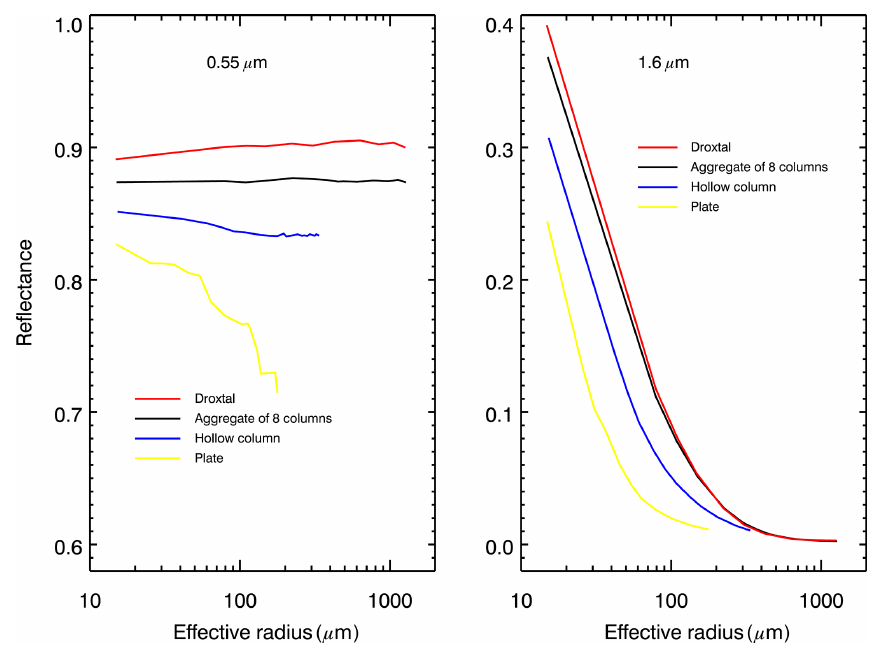
Figure 2. Reflectance of snow layer at 0.55 and 1.6µm calculated assuming different SPSs. Observation/illumination geometry: SZA, VZA and RAA were set to 70, 30 and 135 ◦ ,